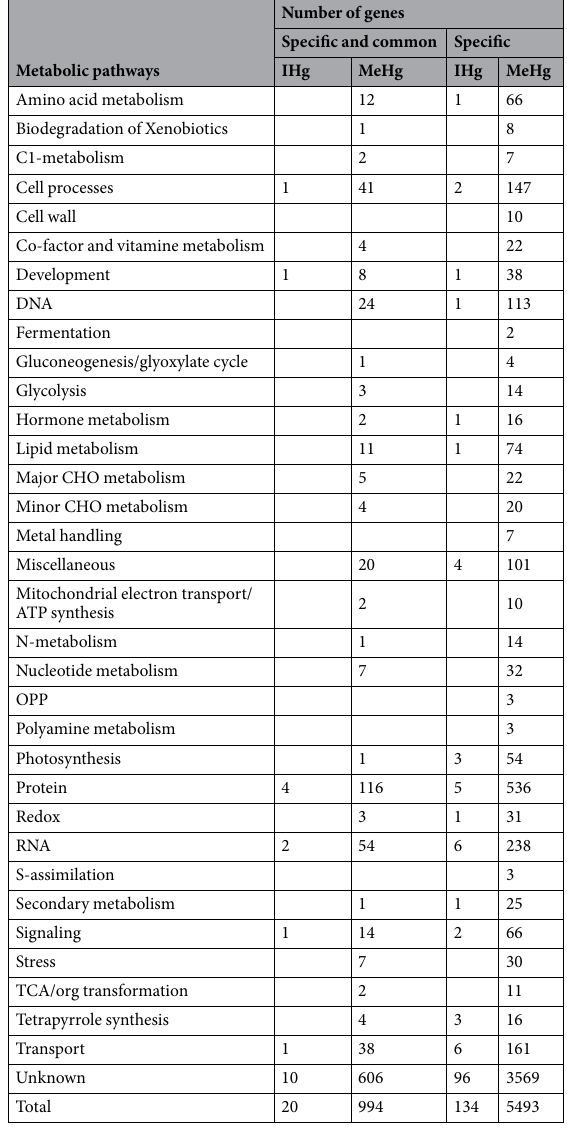
Table 3. Number of significantly dysregulated genes in metabolic pathways (MapMan) specifically responding to IHg or MeHg (specific) and common to all tested concentrations (specific and common) in C. reinhardtii after 2 h